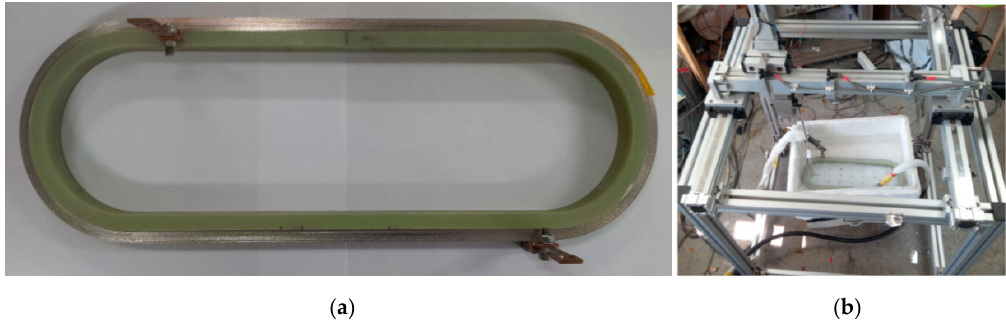
Figure 6. ( a ) Pictures of the fabricated NI HTS field coil, and ( b ) test set-up.